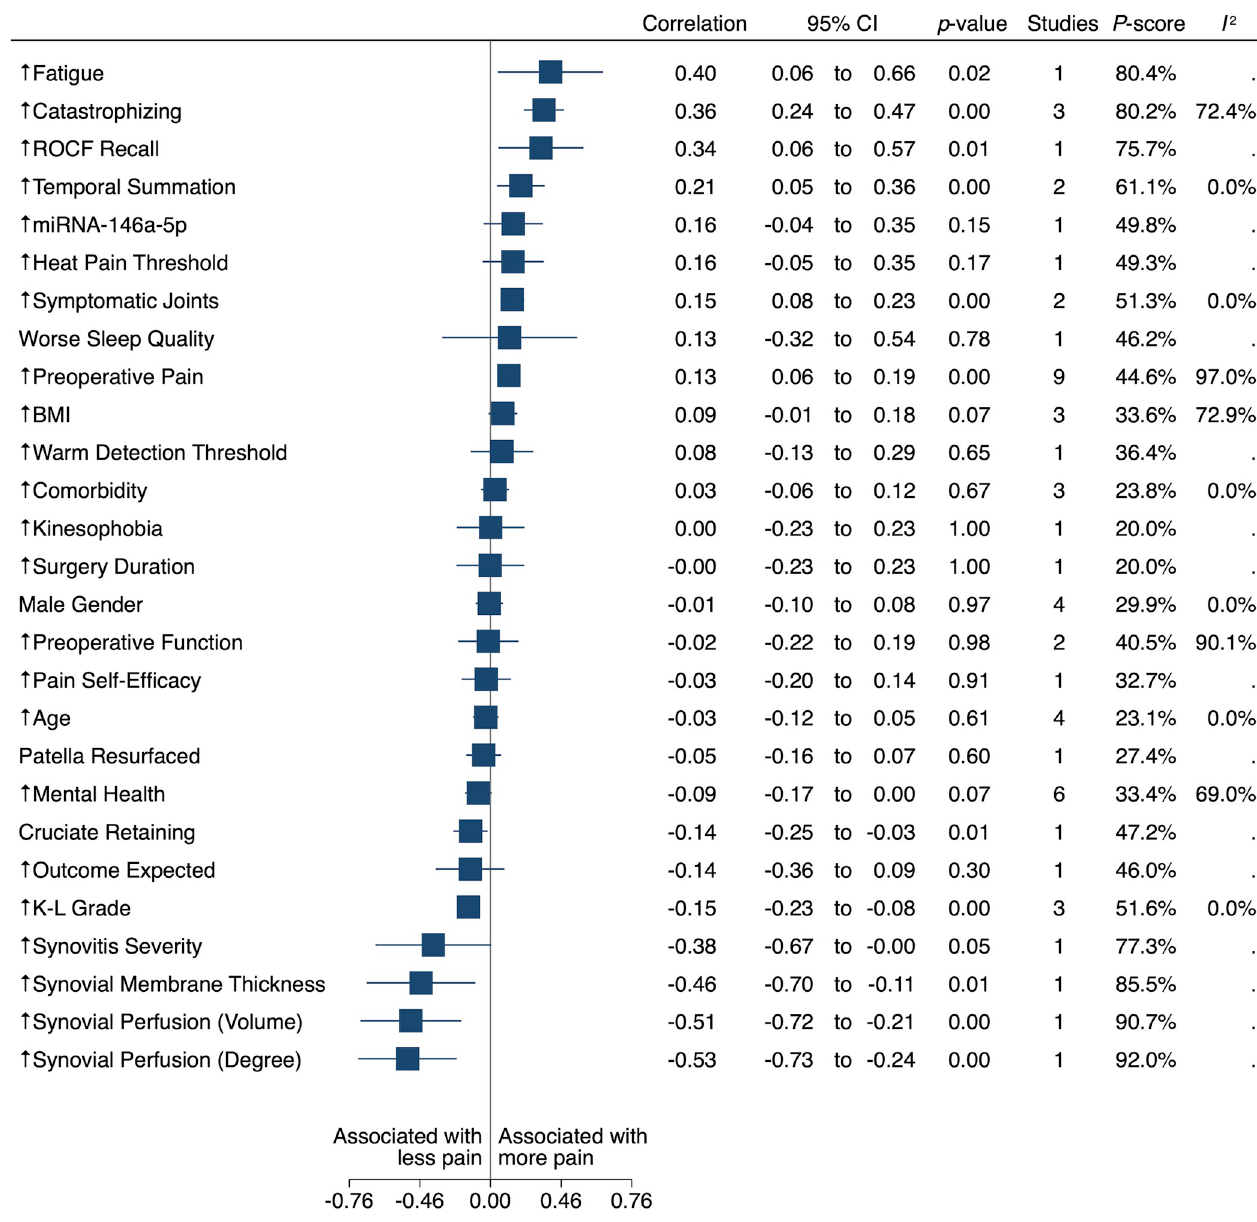
Fig 2. Forest plot of factors associated with pain at twelve